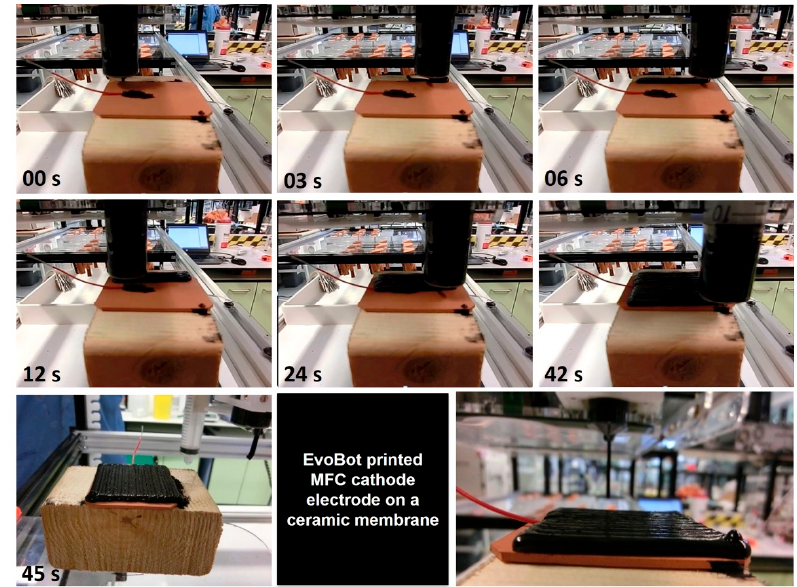
Figure 5. Time-lapse photographs of the EvoBot extrusion of the PTFE-free/alginate-based cathode electrode on a ceramic MFC membrane in less than a minute.